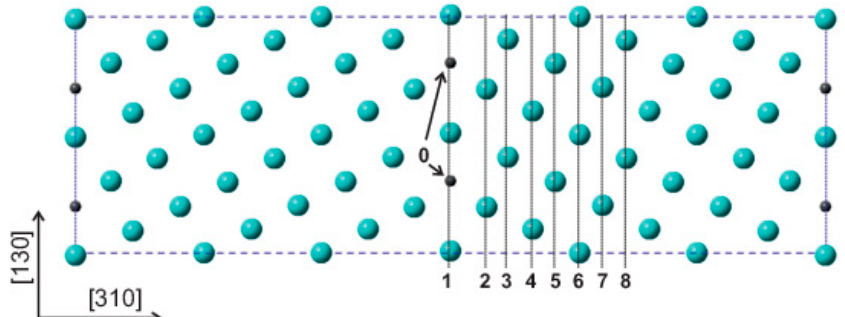
Figure 1. Illustration of the computational supercell with numbered inequivalent atomic planes (starting from the grain boundary). The interstitial positions are labeled as zero. The supercell contains two grain boundaries and we consider the segregation of impurity atoms at both of them to keep the supercell symmetrical.